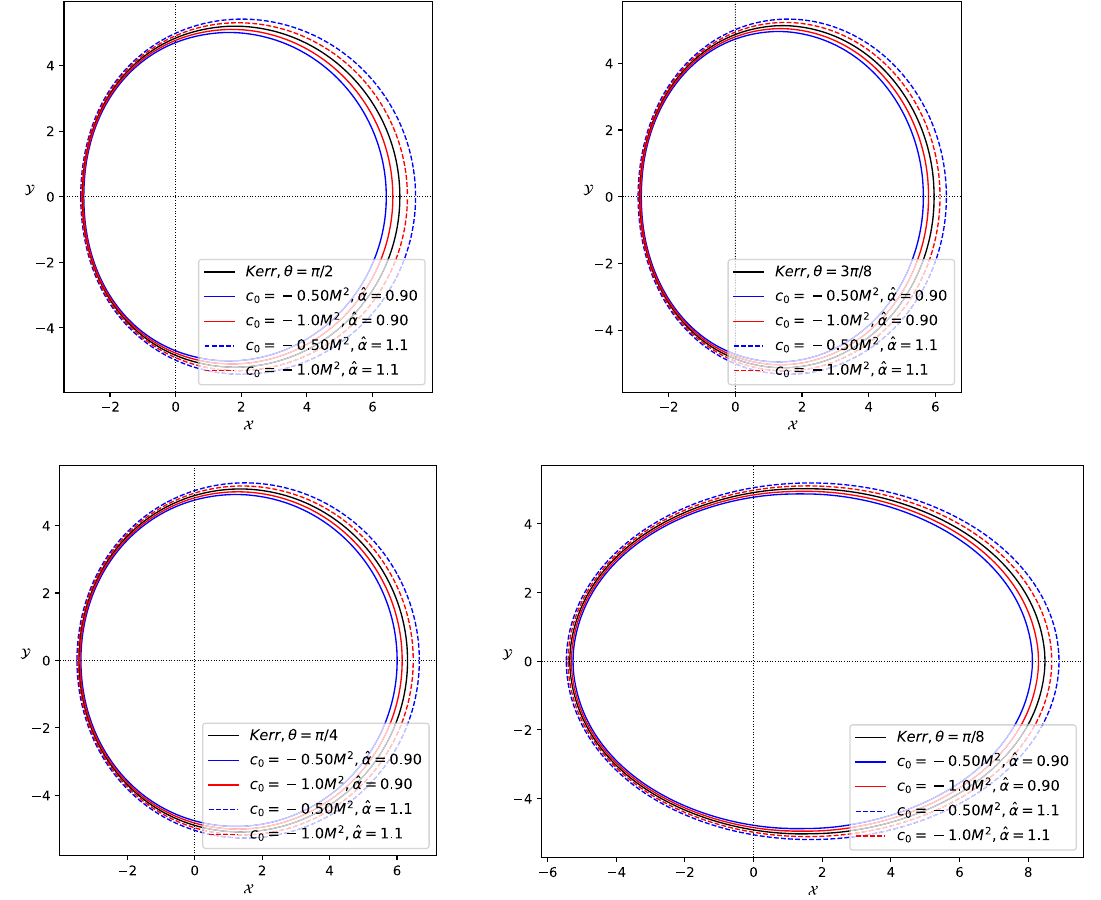
Fig. 3 Shadow plot for different inclination angles for the black hole spin parameter a = 0 . 90 M (aspect ratios of figures are set to obtain the actual